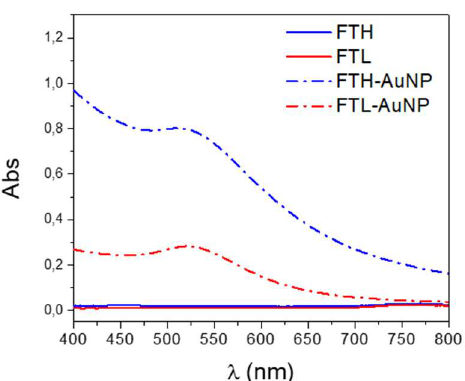
Figure 2. Absorbance spectra of FT-AuNP samples. Gold-containing samples (FTH-Au NP and FTL-Au NP) are represented by dash-and-dot lines to compare them to the apo-forms of FTH and FTL shown as continuous lines.